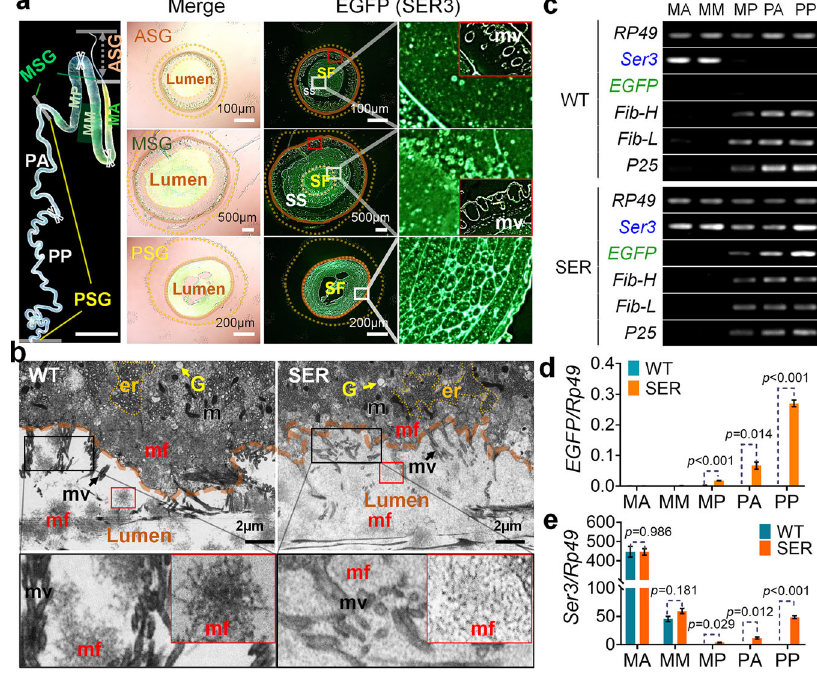
Fig. 4 | Synthesis and secretion of silk proteins in SGs of mutant 5th instar larvae. a Frozen section of the SG cross-section. The state of the SER3 protein secreted into the lumen of the SG, was detected by EGFP-fusion expression. b Transmissionelectron micrograph ofthe PSG. Fig.4a and b: SF, silk fi broinlayer; SS, silk sericin layer; er, endoplasmic reticulum; G, Golgi apparatus; m, mitochon- drion;mf, fi broinmass;mv,microvilli. c Semi-quantitativePCRand d , e qRT-PCRto detectthemRNAlevelsofEGFP,SER3,andsilk fi broinFib-H,Fib-L,andP25genesin